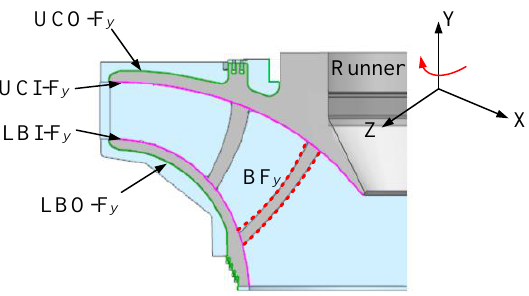
Figure 8. The exploded view of the axial water thrust of the runner.